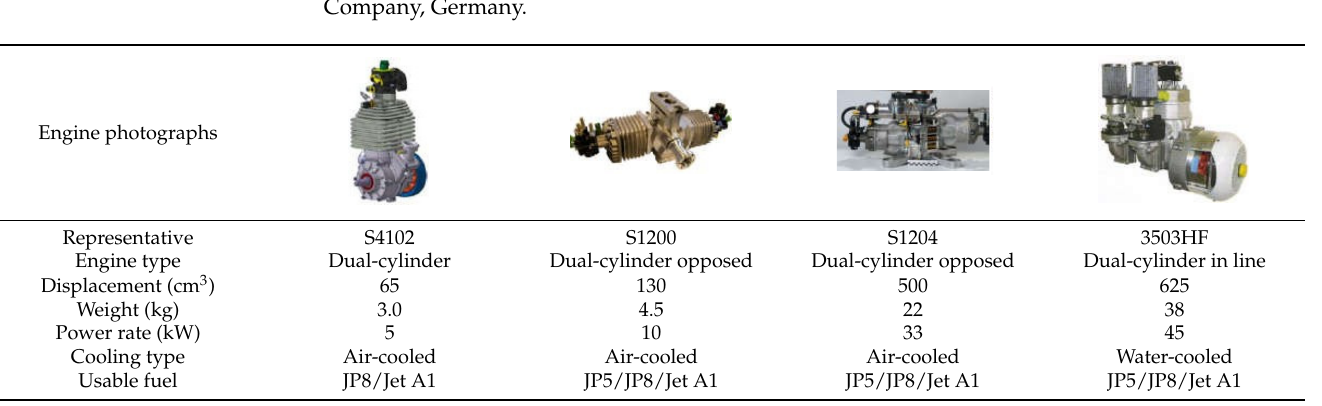
Table 2. Heavy-oil, two-stroke, direct-injection, spark-ignition, piston engine produced by the Hirth Company, Germany.